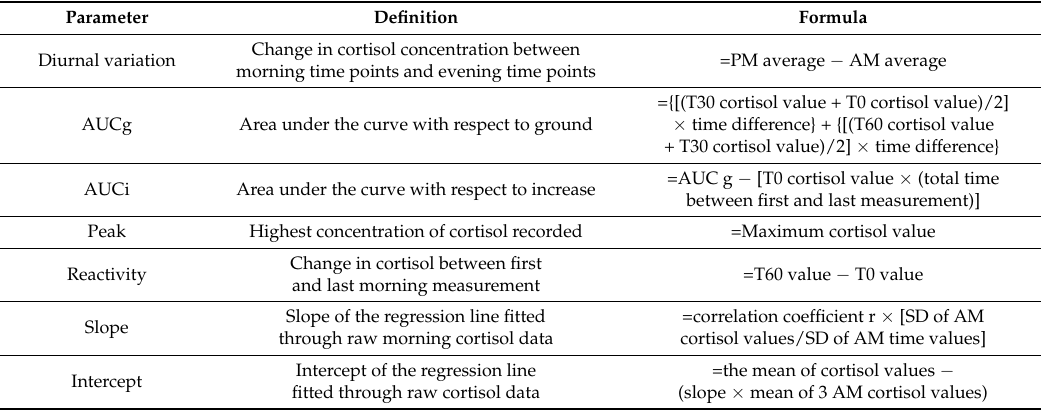
Table 5. Cortisol awakening response parameter